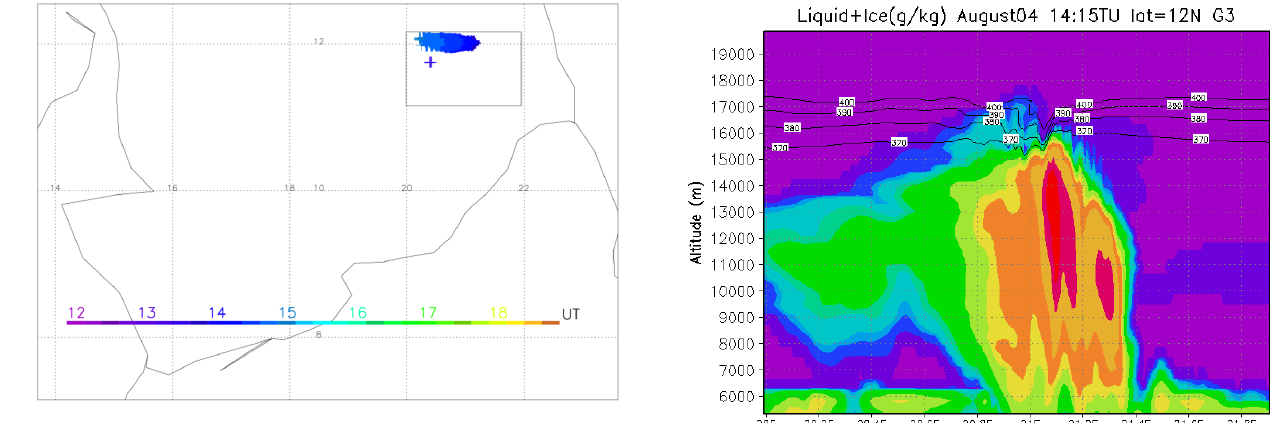
Fig. 8 Fig. 8. Chad case BRAMS simulation. Grid 3 time evolution of the grid points having an ice mixing ratio higher than 0.05gkg − 1 Fig. 9 Fig. 9. Longitude/Altitude cross-section of condensed water mixing above the tropopause (380 K). The same color scale as in Fig. 3 is ratio (gkg − 1 ) around the overshoot location inside Grid 3 at 12 ◦ N chosen. latitude and 14:15UT on 4 August 2006. The solid lines indicate the isentropic levels 370, 380, 390 and